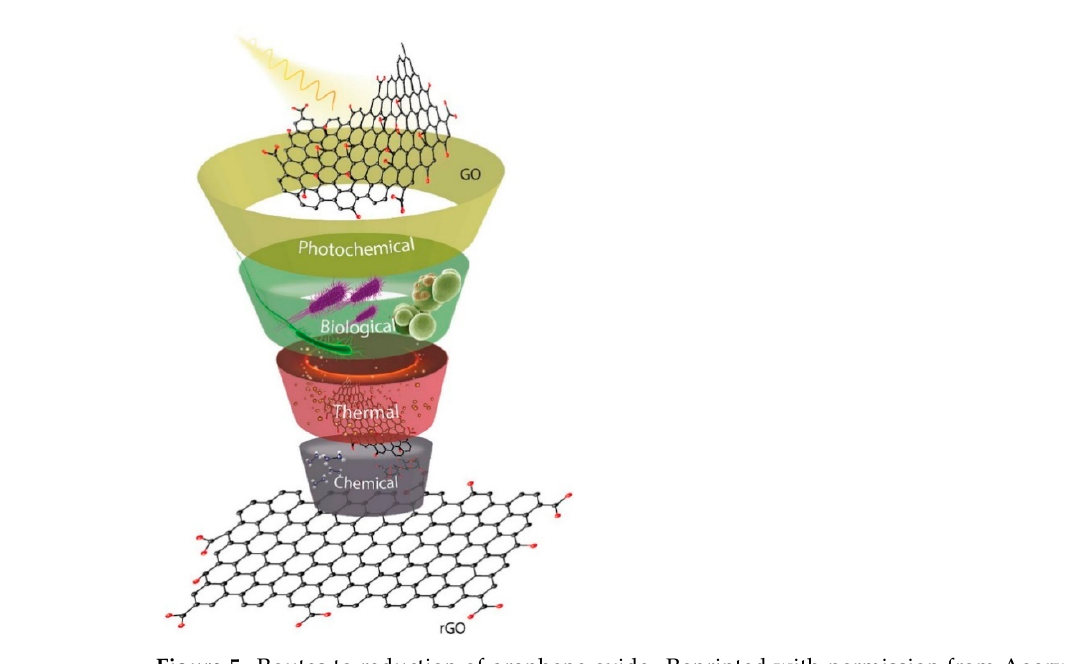
Figure 5. Routes to reduction of graphene oxide. Reprinted with permission from Agarwal and Zetterlund [100]. Copyright (2021) Elsevier.